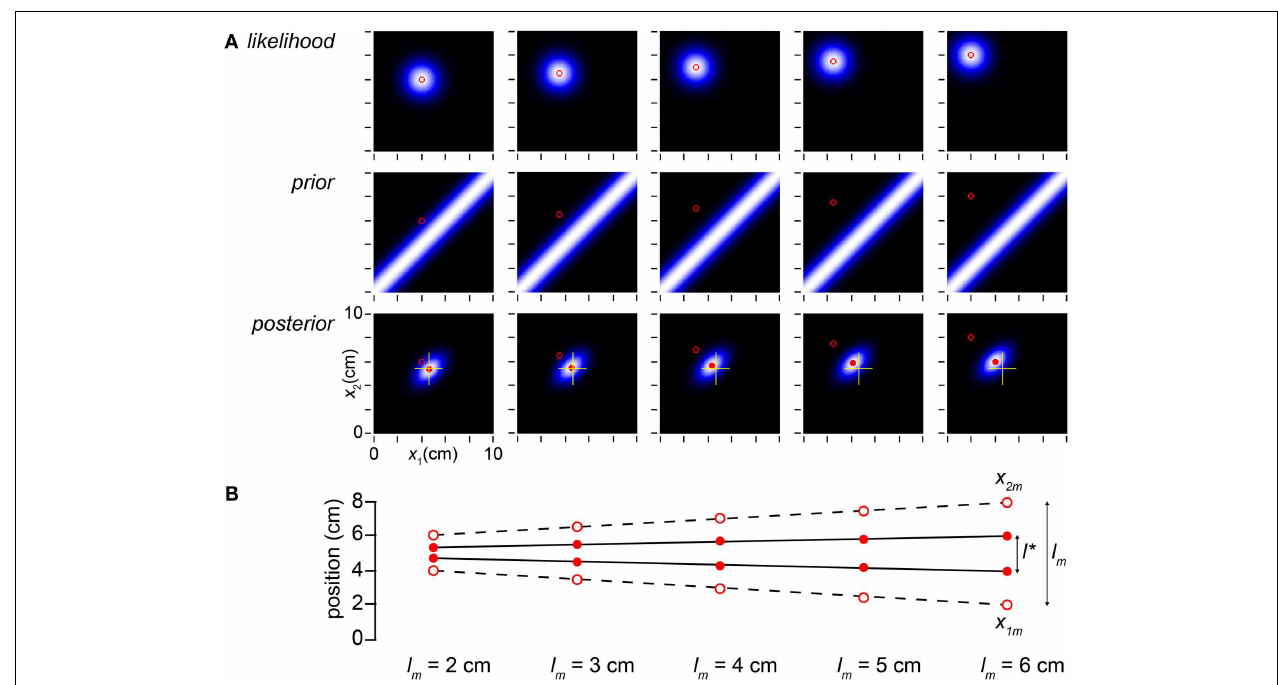
crosshairs in all posterior plots mark the posterior mode in the leftmost column. (B) The measurements, x 1 m and x 2 m , are plotted as open circles; the observer’s percept (mode of the posterior), as filled circles. l * grows linearly with, but consistently underestimates, l m (compare to Figure 1A , lower).The measurements ( x 1 m , x 2 m ) were, from left to right: (4, 6cm), (3.5, 6.5cm), (3, 7cm), (2.5, 7.5cm), and (2, 8cm). In all panels, σ s = 1cm, σ v =